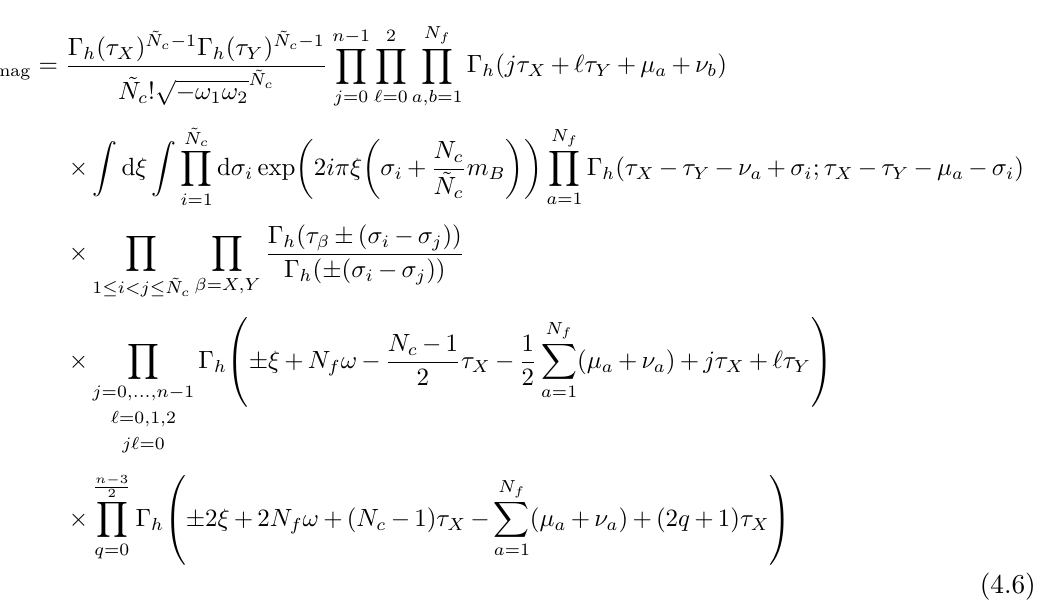
Table 2 . Matter content of the electric (upper) and magnetic (lower) theories after gauging the topological symmetry. The subscript shows the charge of the fields under the gauged U (1) and the magnetic partition